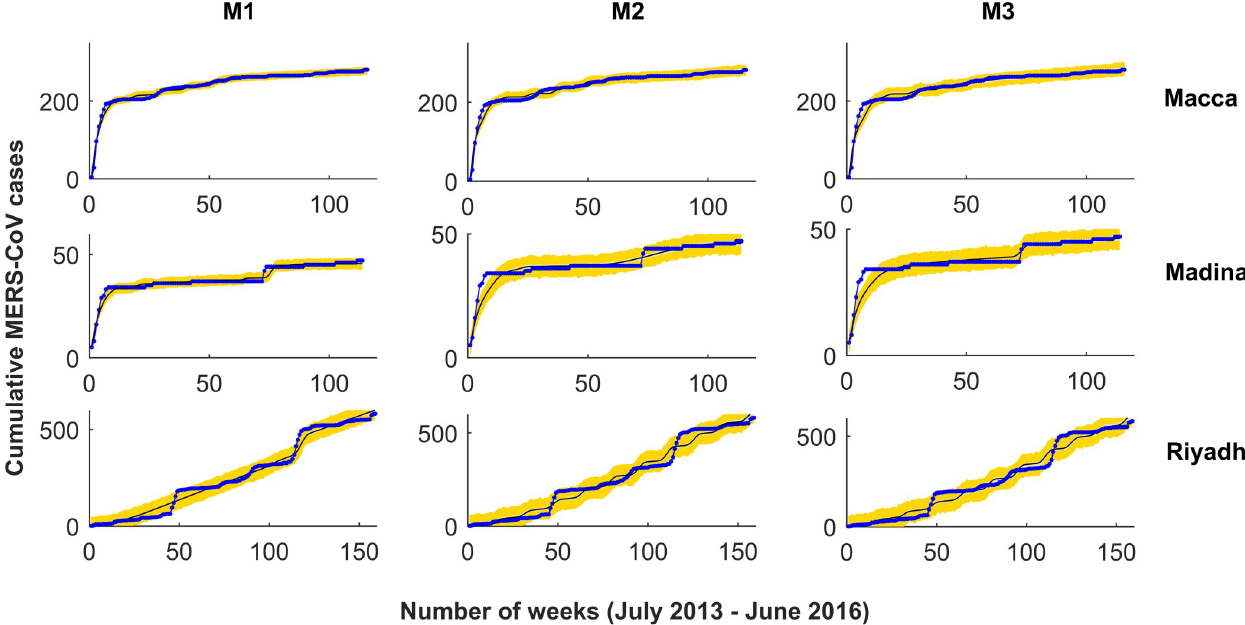
Fig 3. Model simulations fitted to accumulated MERS-CoV clinical cases in Macca, Madina and Riyadh. Observed data points are shown in blue and the solid line depicts the model solutions. The three two-strain models fitted to cumulative MERS-CoV cases are: M1: 2-strain model with bilinear incidence, M2: 2-strain model with non-monotone incidence, and M3: 2-strain model with saturated